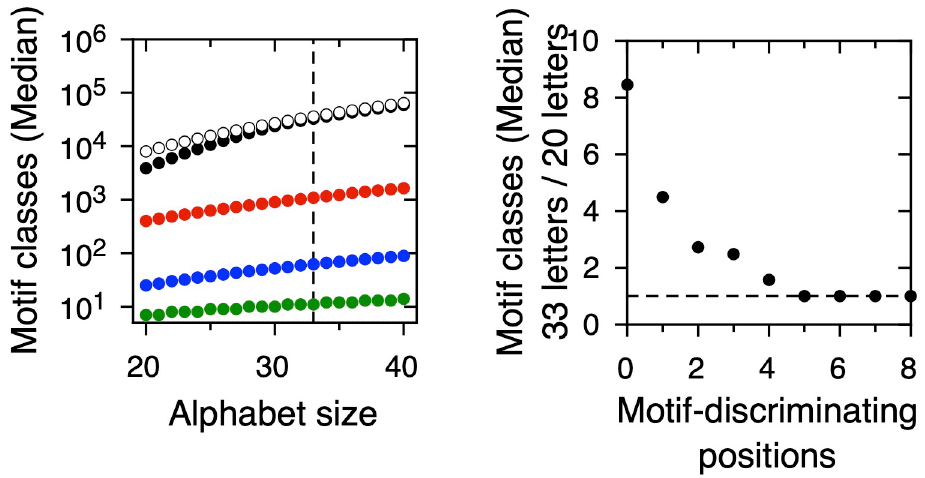
Fig 5. Number of potential linear motif classes as a function of protein alphabet size. (Left) Number of potential linear motif classes for different numbers of motif-discriminating positions, as a function of alphabet size. Black: 0 positions. White: 1 position. Red: 2 positions. Blue: 3 positions. Green: 4 positions. The dashed vertical line highlights the results for an alphabet size of 33 amino acids. (Right) Quotient of the number of potential linear motif classes for alphabet sizes of 33 and 20, as a function of the number of motif-discriminating positions.